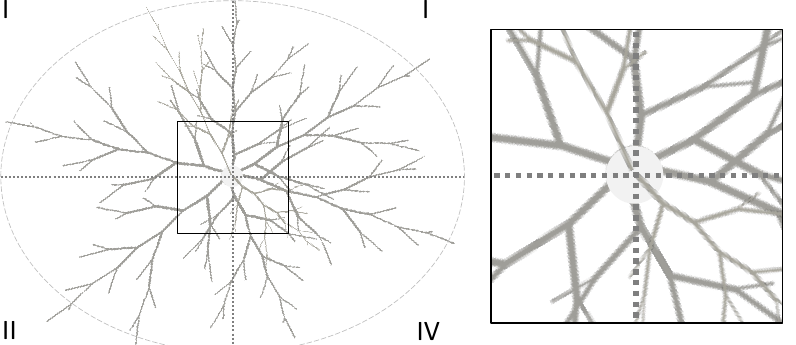
Figure 5. Schematic representation of the branches in the crown, projected onto a horizontal plane, where we assumed an ellipsoidal shape of the crown projection with the semi-axes centered at the stem axis and thus defining four quadrants (I – IV). The returns in the surface of the stem were manually removed.